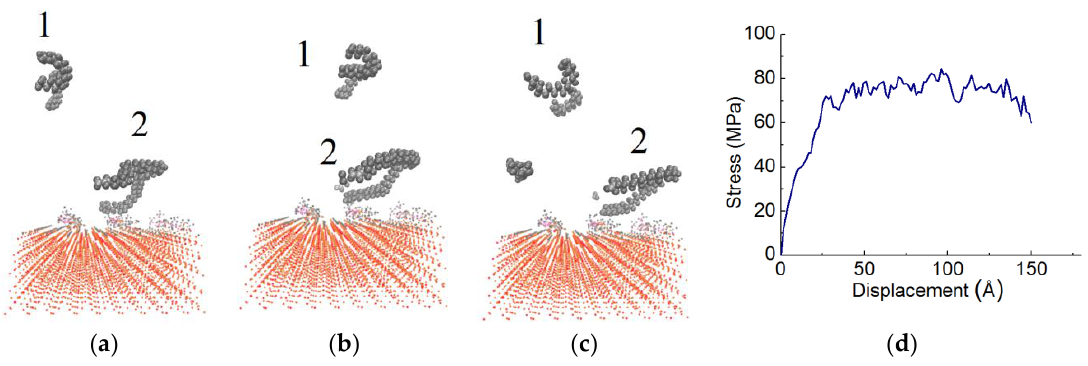
Figure 11. Snapshots of shear simulation of PE(150 – 40)/mS1 interface at various displacements: ( a ) 2 Å , ( b ) 50 Å , ( c ) 100 Å , and ( d ) the stress curve.